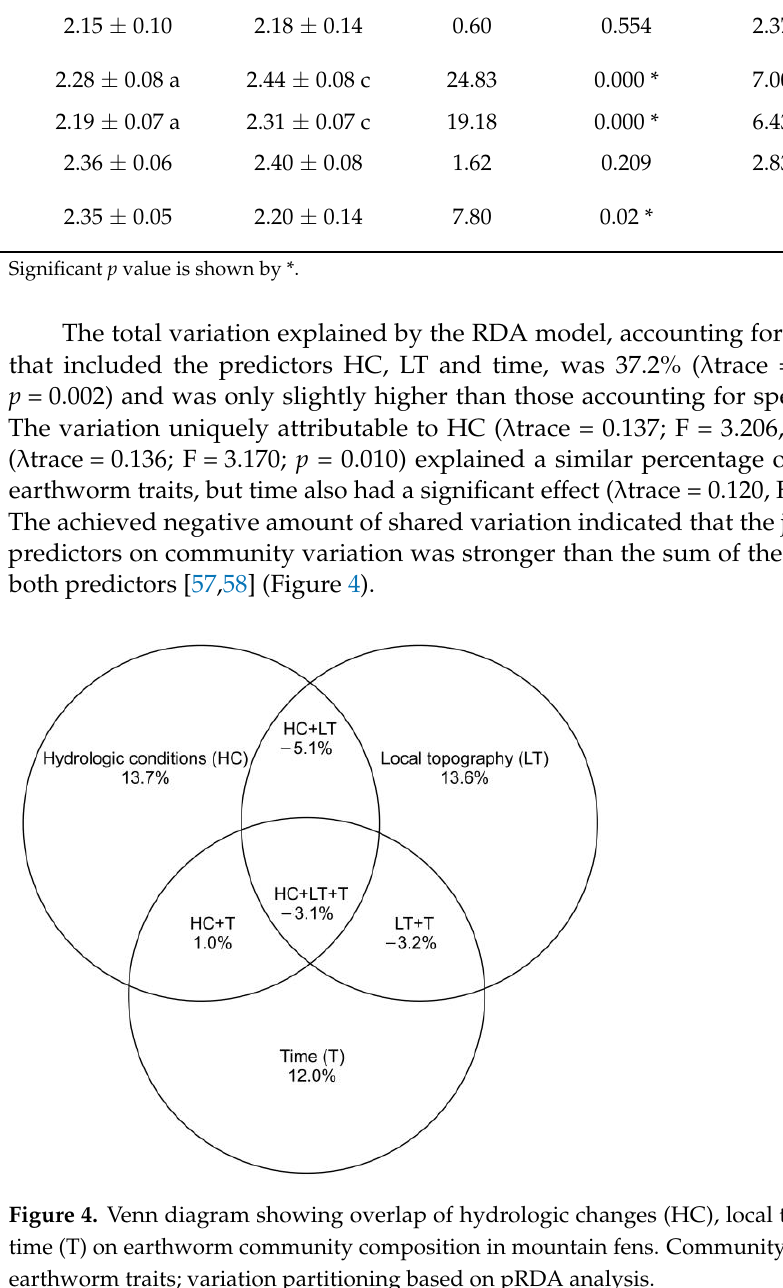
Figure 4. Venn diagram showing overlap of hydrologic changes (HC), local topography (LT) and time (T) on earthworm community composition in mountain fens. Community composition fit with earthworm traits; variation partitioning based on pRDA analysis. The main environmental variables predicting trait variation among earthworm com- munities were related to semi-natural fen HC conditions, elevation, size and time (2010 year) (conditional effect; Table